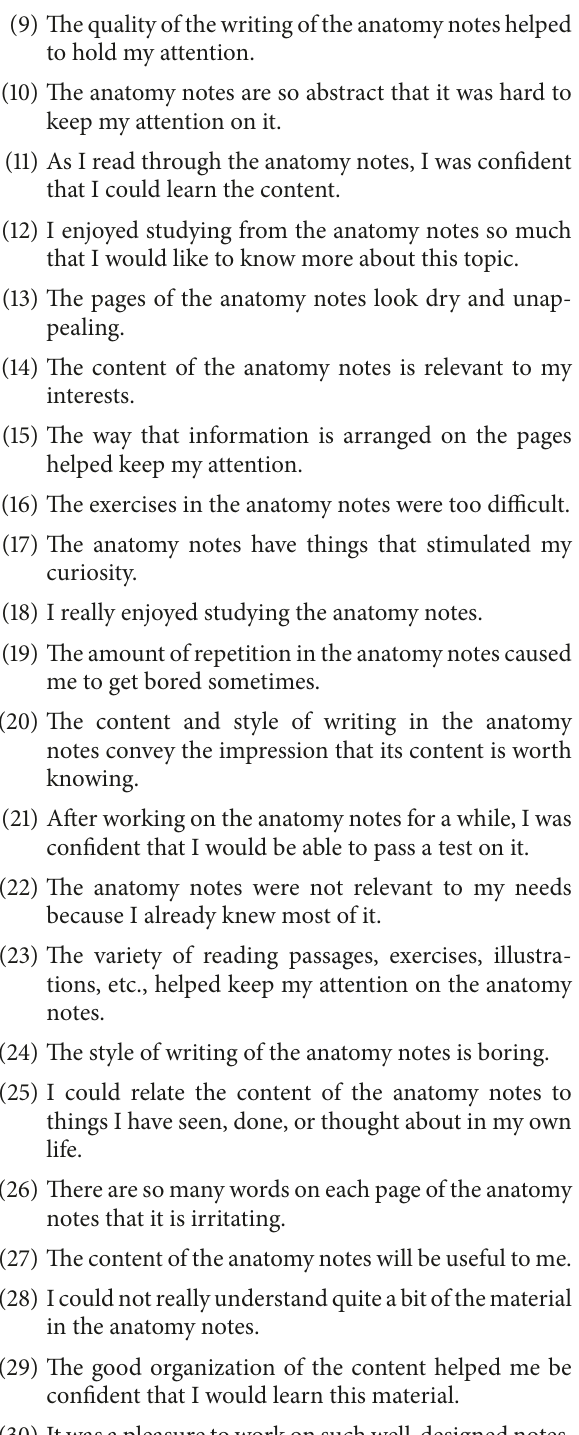
Table 5: IMMS scoring guide [17].